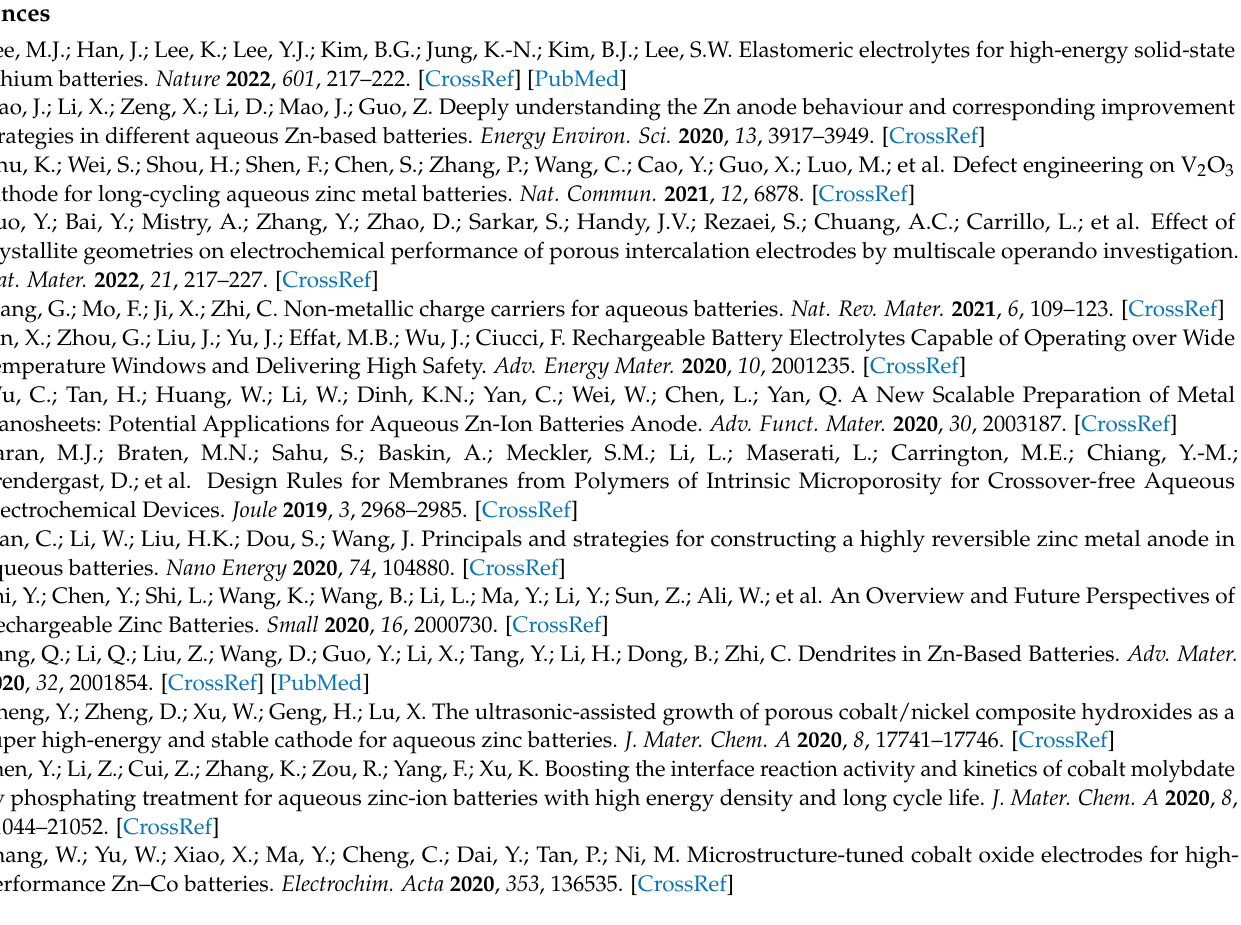
Figure S2: Comparison of diffraction peaks between 32 ◦ to 40 ◦ in FNCH and NCH; Figure S3: CV curves (a) and GCD curves (b) of NCH; Figure S4: Ball and stick models of the structure of NCH (a) and FCNH (b); Figure S5: Models of the calculation of OH- adsorption on NCH (a) and FNCH (b); Figure S6: CV curves (a) and GCD curves (b) of NCH//Zn battery; Table S1: The results of SEM EDX